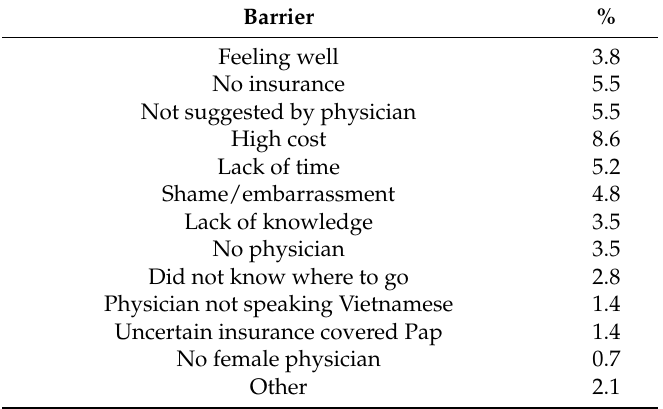
Table 2. Specific reasons given for not having a Pap test among Vietnamese American women